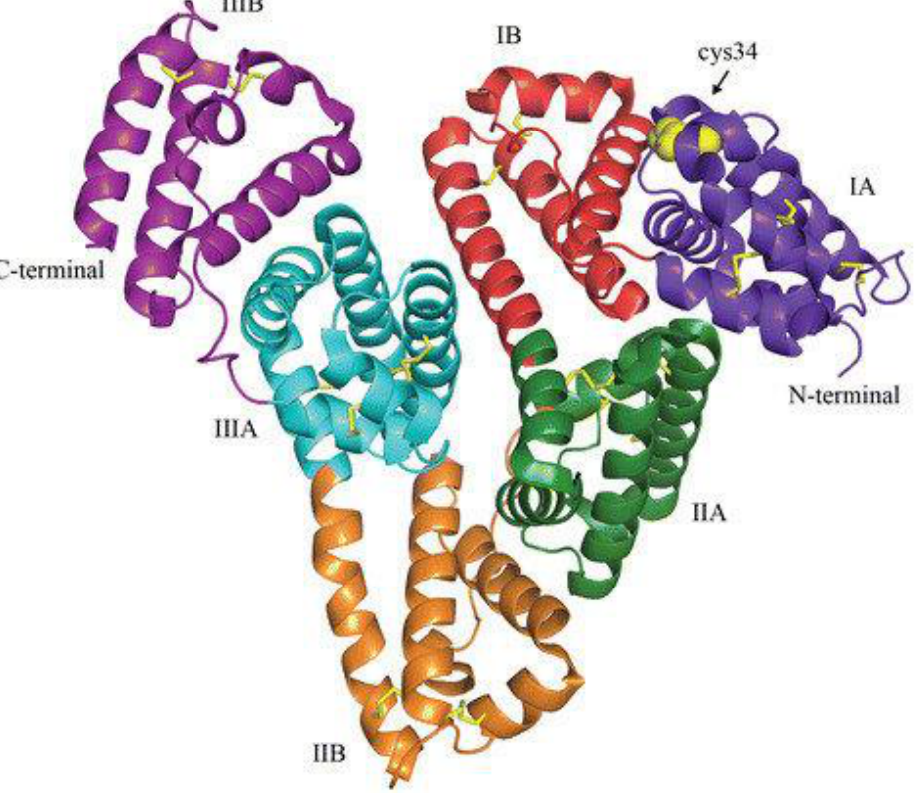
Figure 7. The 3D structure of HSA [153].